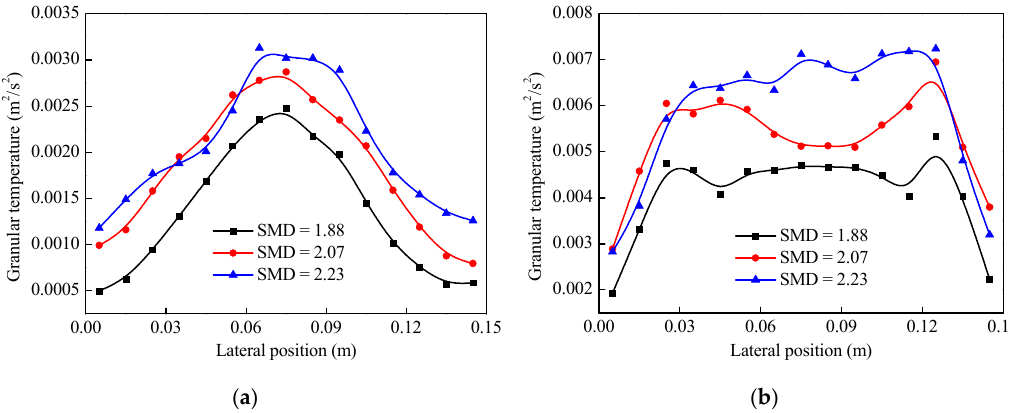
Figure 13. Time-averaged granular temperature difference between small and large particles at different heights: ( a ) 0.05 m; ( b ) 0.1 m.